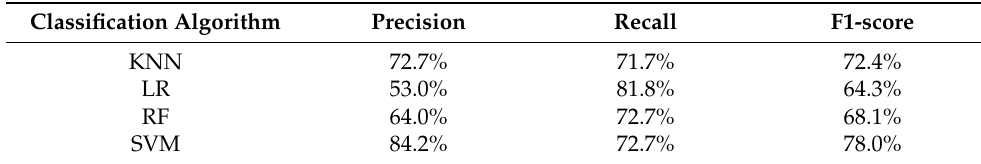
Table 4. Precision, recall, and F1-score of KNN, LR, RF, and SVM on robust data after being filtered by multi-source semantic information.